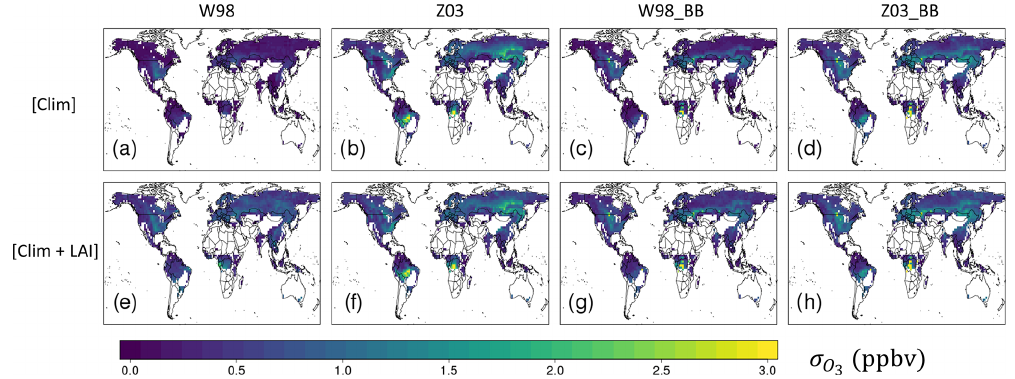
Figure 11. Estimated contribution of IAV in July mean daytime v d to IAV of July mean surface ozone ( σ O land